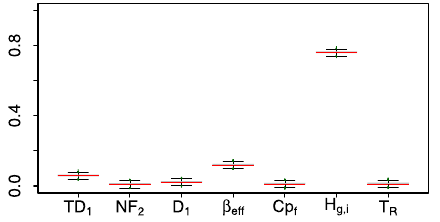
Fig. 17. H 3 D gap Shapley indices for IBE UQ